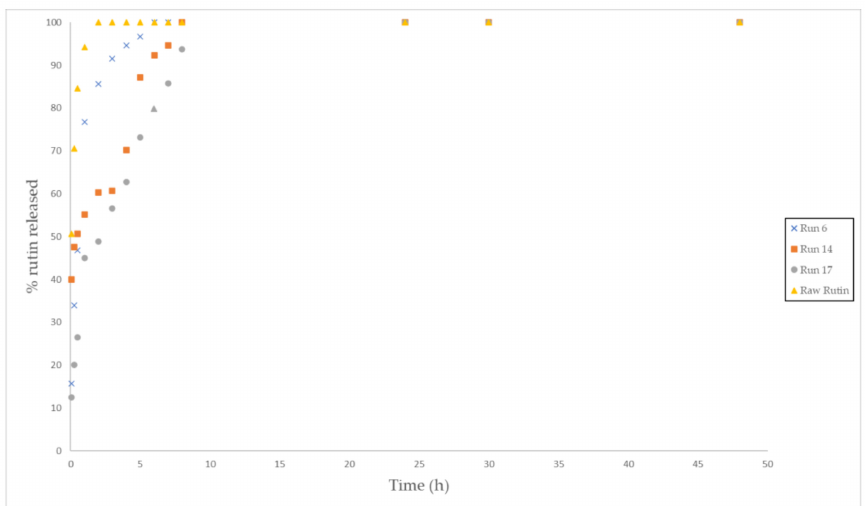
Figure 15. Standardized pareto diagram corresponding to the percentage of rutin released into the PBS solution after 8 h.